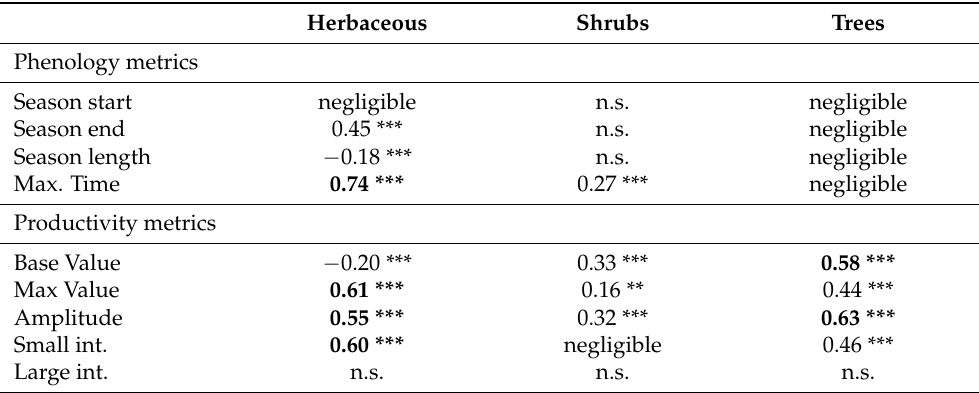
Table 5. Effect sizes (Cliff’s delta values, d) and Mann-Whitney U test results comparing the magni- tude of the temporal changes observed in the north and the south sectors. High positive delta values indicate a higher magnitude of change in the south sector when compared with the north sector (and vice-versa for negative values, see text). Mann-Whitney U test p -values: ** p < 0.01, *** p < 0.001, n.s. p > 0.05. Effect sizes under 0.147 are considered negligible. Effect sizes are considered negligible if |d| < 0.147 and large (in bold) if |d| >